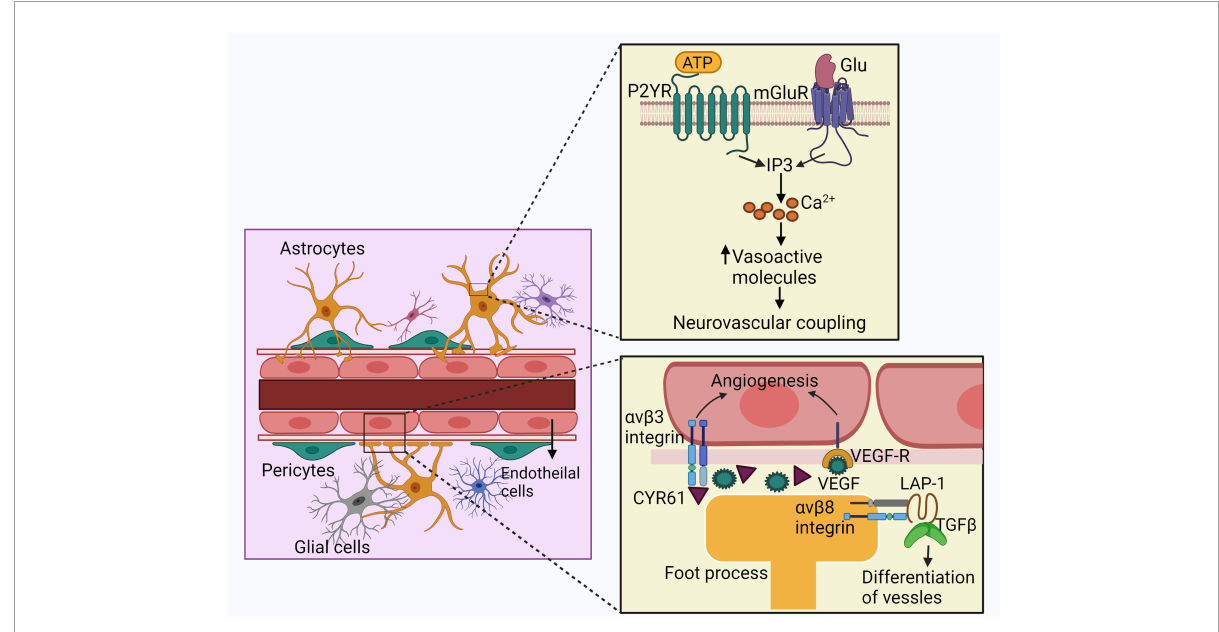
FIGURE3 Schematic representation of the effects of astrocytes on bAVM pathogenesis. Astrocytes express mGluR and P2YR which interact with glutamate or ATP. Activation of these receptors trigger IP3 signaling cascade and the intracellular calcium currents, leading to the release of vasoactive molecules. These agents finally contribute to neurovascular coupling. Astrocytes also release VEGF in bAVM, which delivered to the ECs enhancing angiogenesis. Astrocytes also express CYR61, which takes part in angiogenesis. Foot processes of astrocytes express integrin α v β 8, interacting with LAP and activates TGF- β which promotes differentiation and maintenance of vessels. ECs: endothelial cells, mGluR: metabotropic glutamate receptors, P2YR: purinergic receptors, ATP: adenosine triphosphate, LAP: latency-associated peptide, IP3: inositol